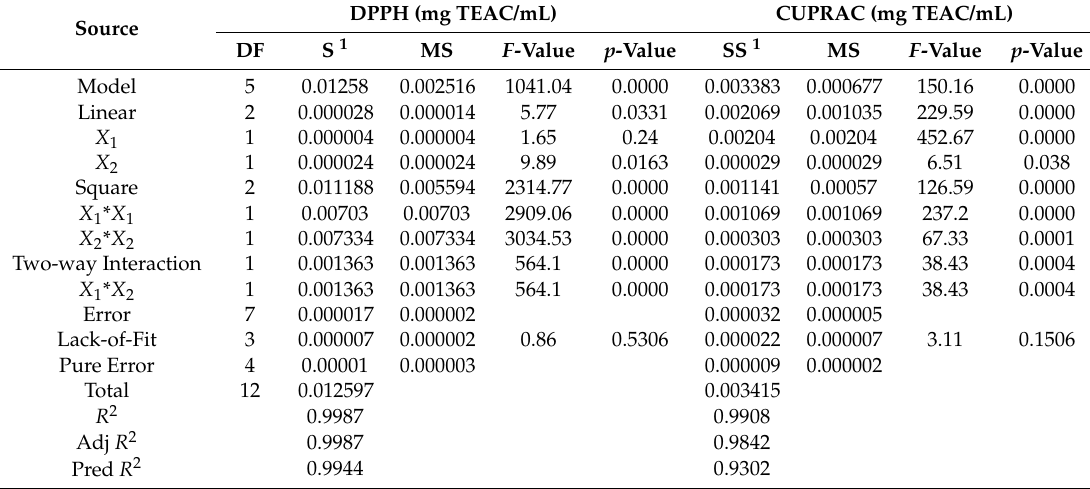
Table 4. Analysis of variance (ANOVA) of responses for 1,1-diphenyl- 2-picrylhydrazyl (DPPH) and cupric reducing antioxidant capacity (CUPRAC)